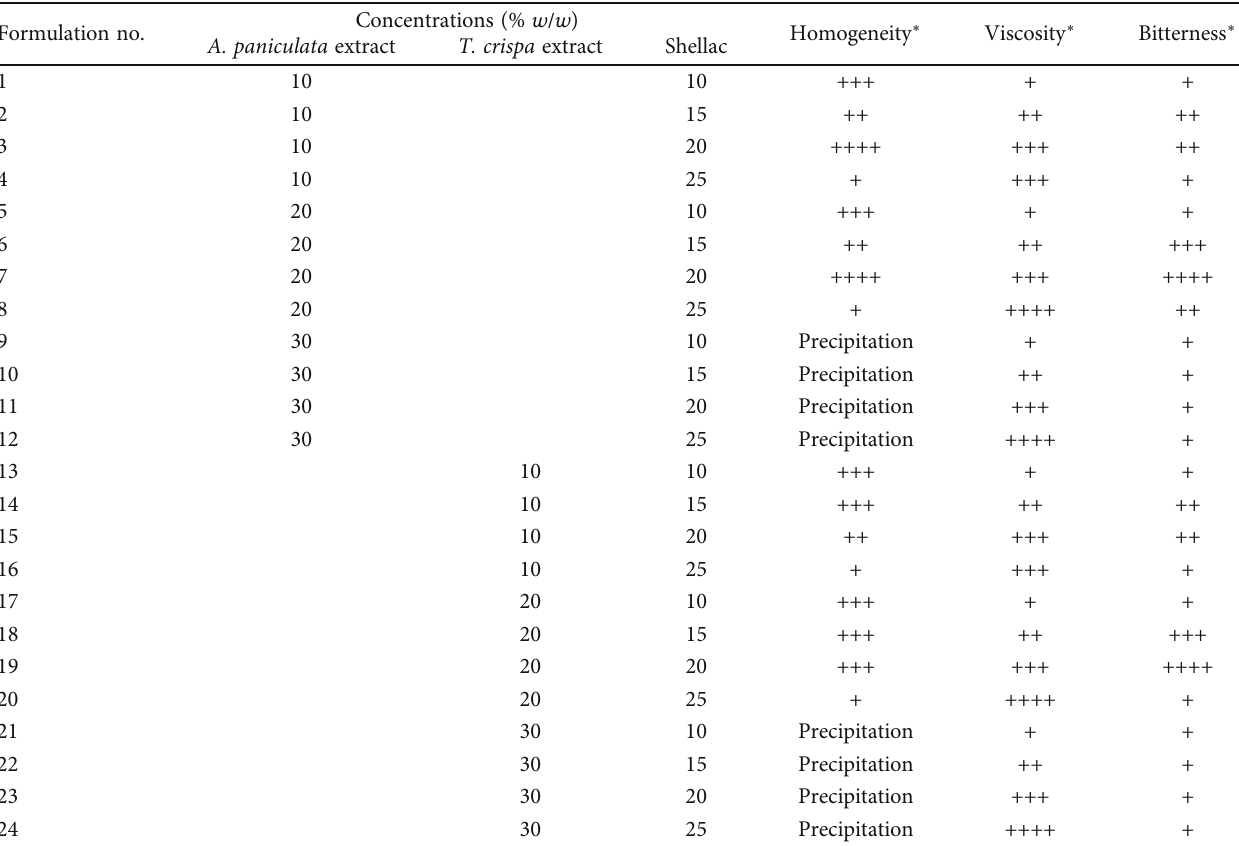
Table 2: Composition, homogeneity, viscosity, and bitterness of nail lacquers containing bitter extract. Formulation no.